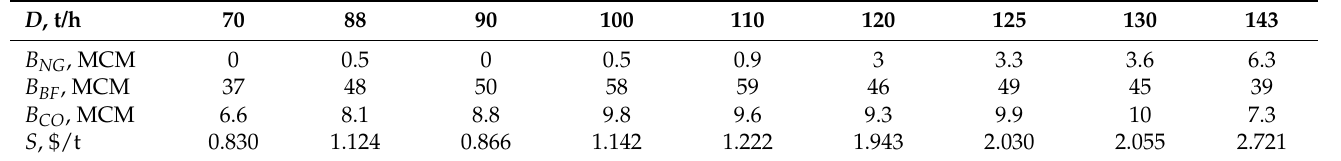
Table 8. Feasibility Model of Boiler No. 3.